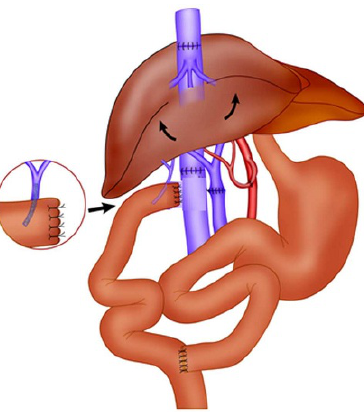
Figure 1 - Surgery scheme for whole liver transplantation. Vascular anastomoses are shown.